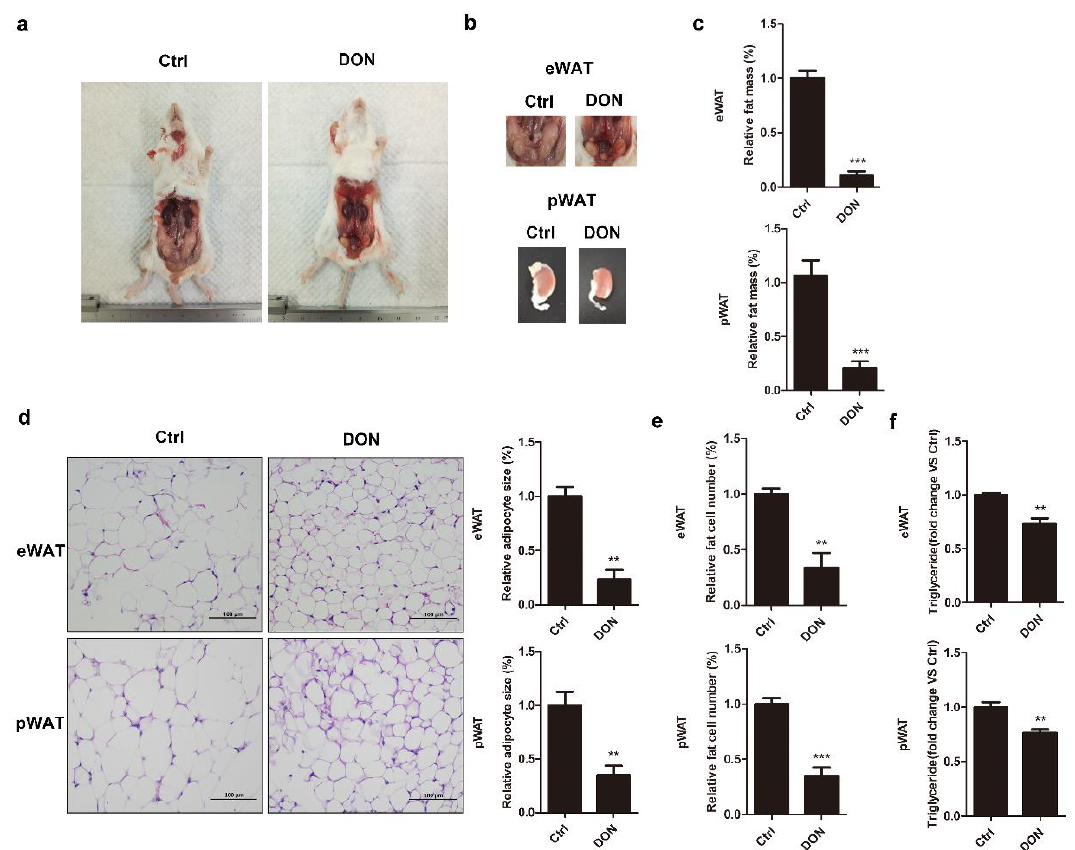
Figure 5. The effect of DON on adipogenesis in mice. Five-week-old SPF male BALB/c mice were randomized into two groups ( n = 5/group)—control group and DON group (3 mg/kg/day)—for four weeks. ( a ) Representative pictures of mice. ( b ) The volume of epididymal eWAT and pWAT. ( c ) The weights of eWAT and pWAT in DON-induced mice compared to those in the control mice. ( d ) Histological analysis of eWAT and pWAT after staining with hematoxylin and eosin (H&E), followed by microscopic analysis. Scale bar is 100 µm (left). Average cell size in DON-induced mice compared to that in the control group (right). ( e ) The relative cell numbers of eWAT and pWAT in DON-induced mice compared to those in the control mice. ( f ) The TG level in DON-induced mice compared to that in the control group. Data are presented as means ± SD, n = 5. The results are representative of three independent experiments, and statistical significance is indicated by ** p < 0.01, *** p < 0.001.